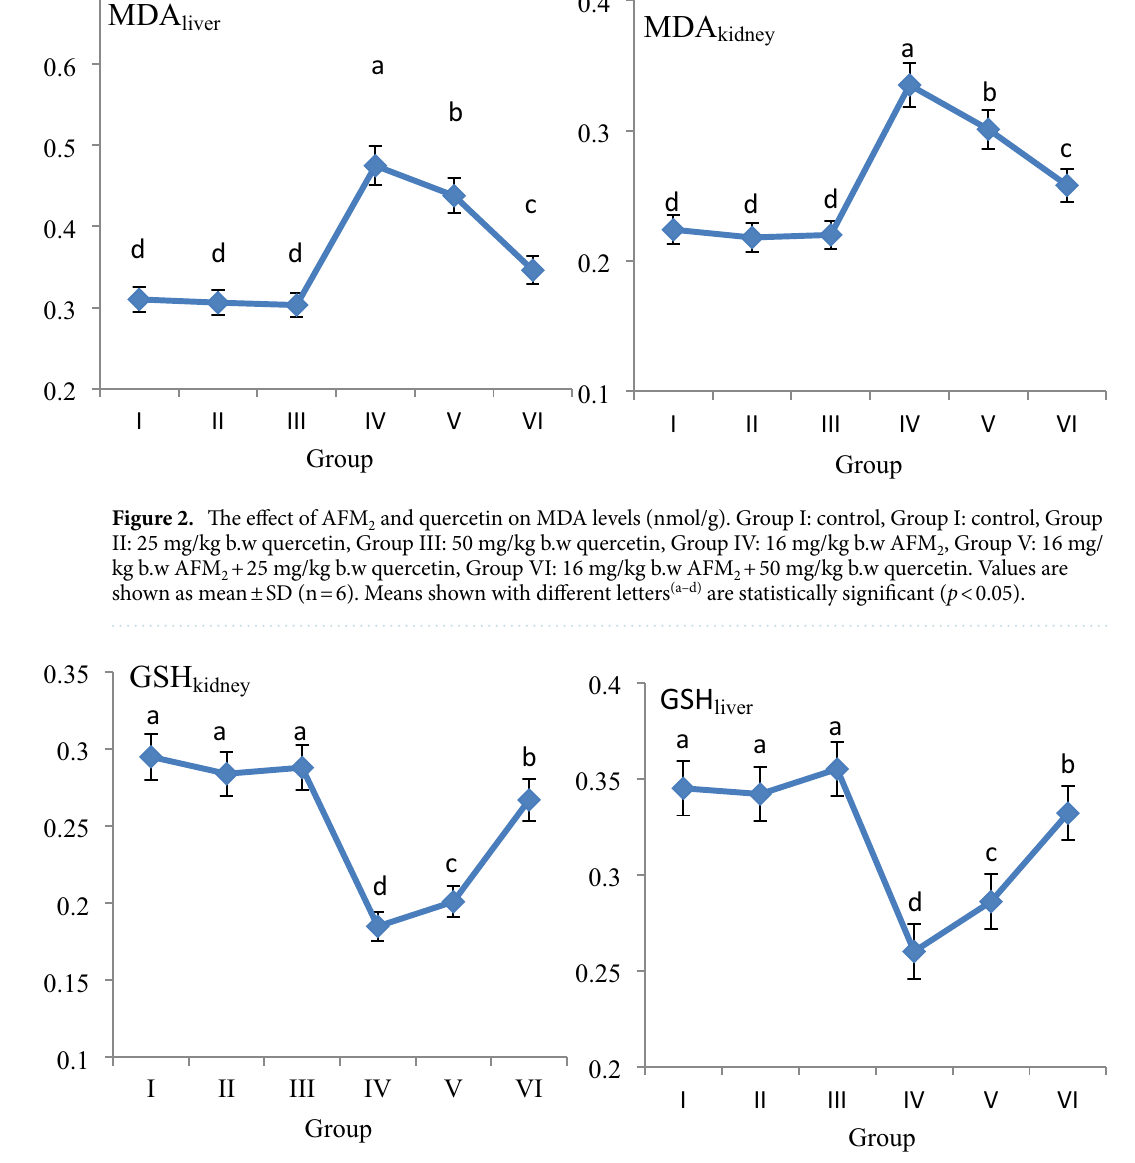
Figure 3. The effect of AFM 2 and quercetin on GSH levels (mg/g). Group I: control, Group II: 25 mg/kg b.w quercetin, Group III: 50 mg/kg b.w quercetin, Group IV: 16 mg/kg b.w AFM 2 , Group V: 16 mg/kg b.w AFM 2 + 25 mg/kg b.w quercetin, Group VI: 16 mg/kg b.w AFM 2 + 50 mg/kg b.w quercetin. Values are shown as mean ± SD (n = 6). Means shown with different letters (a–d) are statistically significant ( p <